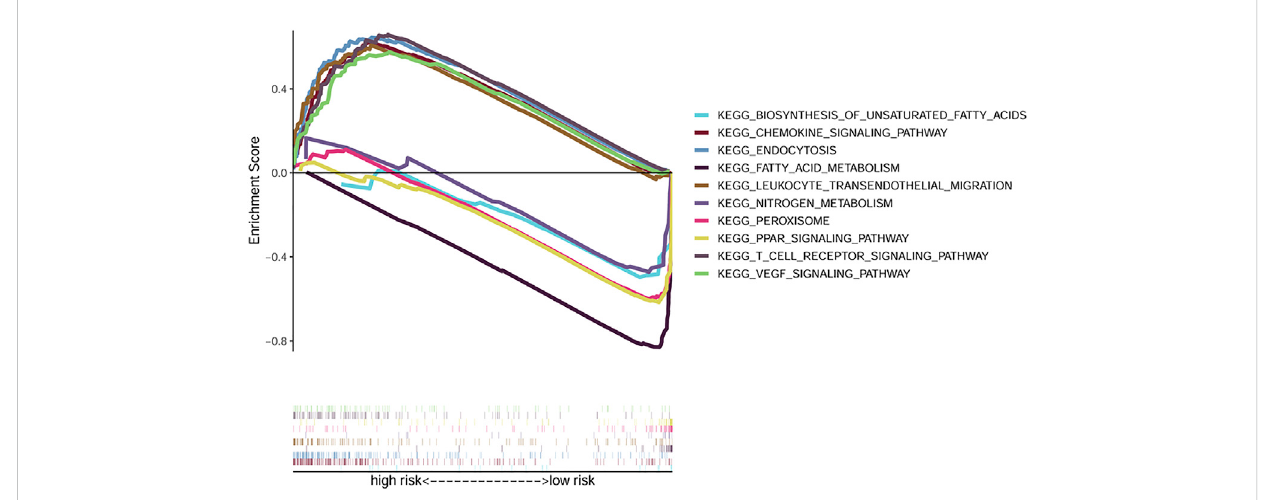
FIGURE 6 GSEA analysis exhibiting the top 5 enriched KEGG pathways in the high and low risk